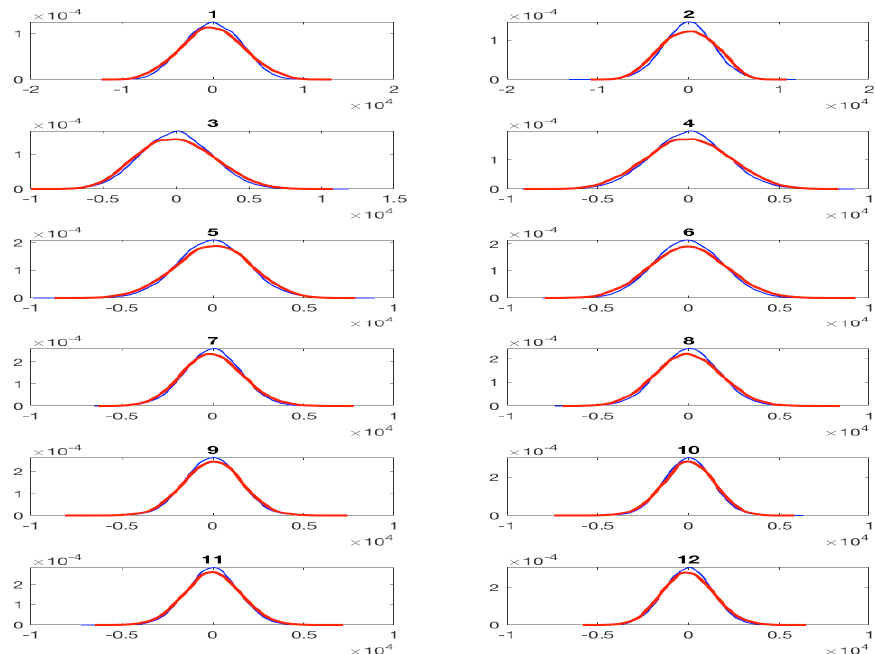
Figure A7. Probability density function (PDF) of the twelve leading PCs of upper-layer stream function anomalies, DAH-filtered in a frequency band f < 5.27 y − 1 : Red, harmonic reconstruction of QG data (HRC; cf. (23)); blue, DAH-MSLM stochastic simulation.